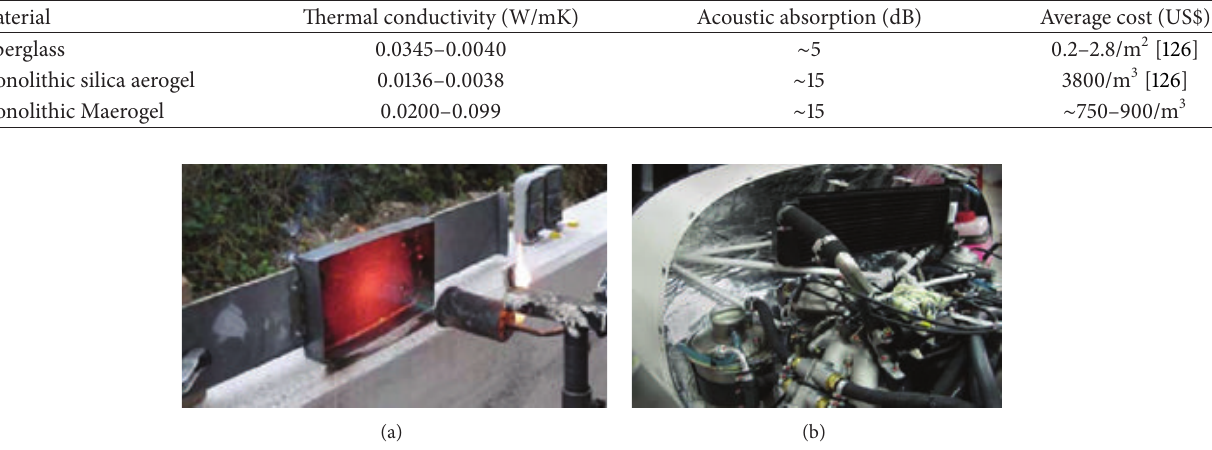
Figure 7: Aerogel firewall during testing. (Image courtesy Aspen Aerogel). Pyrogel 6350 installed in aircraft engine for fire protection (Image courtesy Aspen